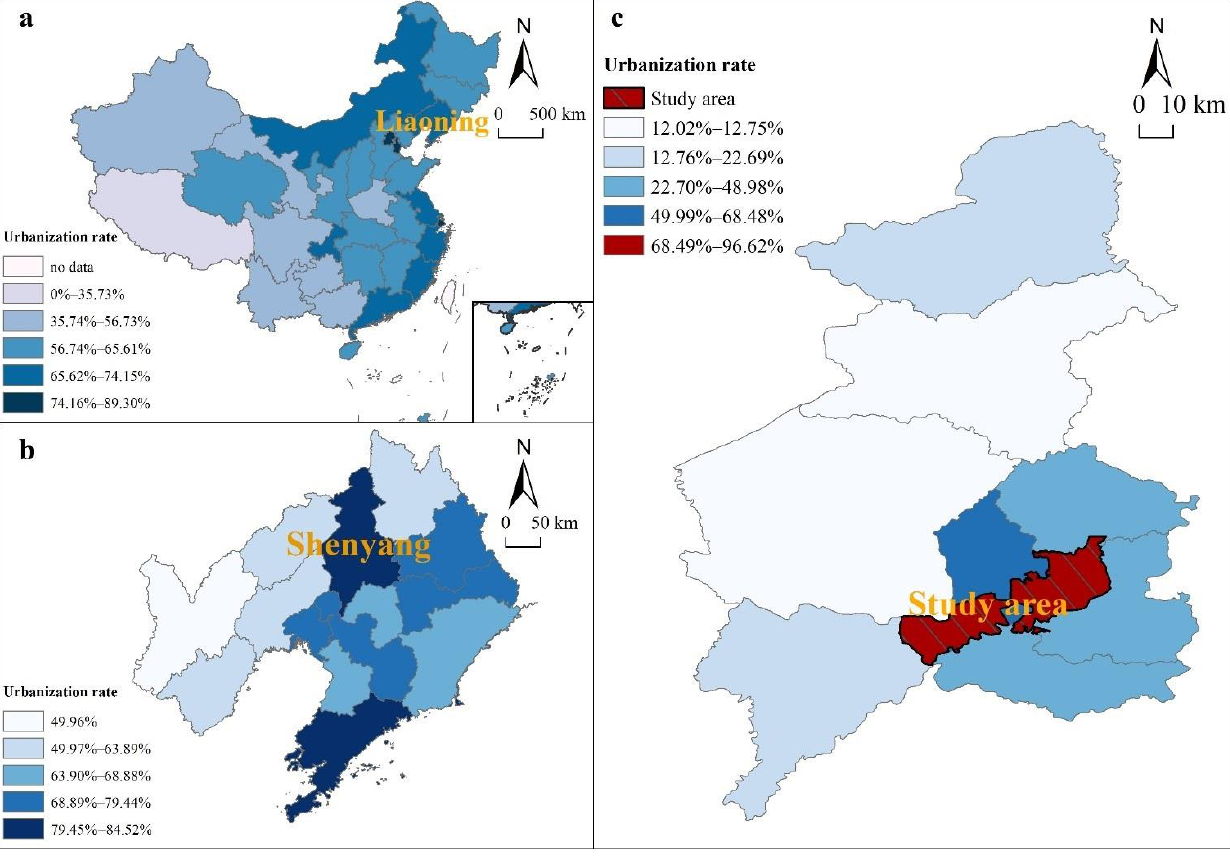
Figure 1. Schematic diagram of the study area: ( a ) the urbanization rate of China’s provinces; ( b ) the urbanization rate of cities in Liaoning Province; ( c ) the urbanization rate of districts of Shenyang.